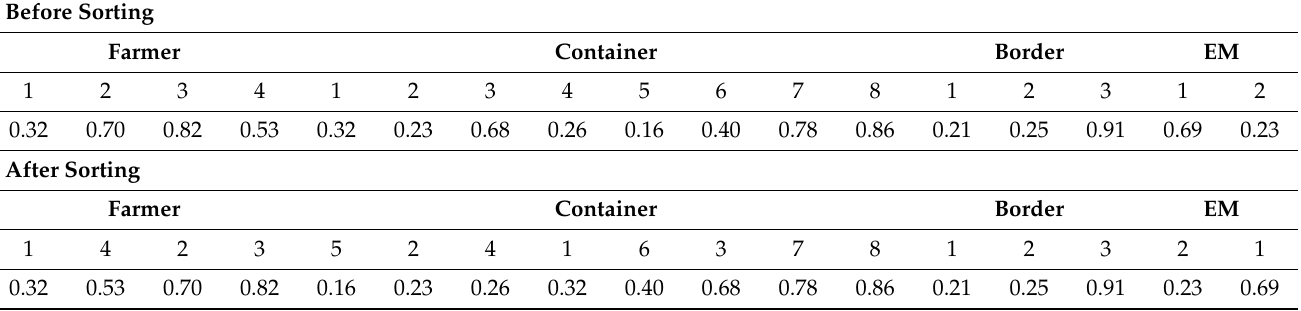
Table 6. Results of the sorting of WP number 1.